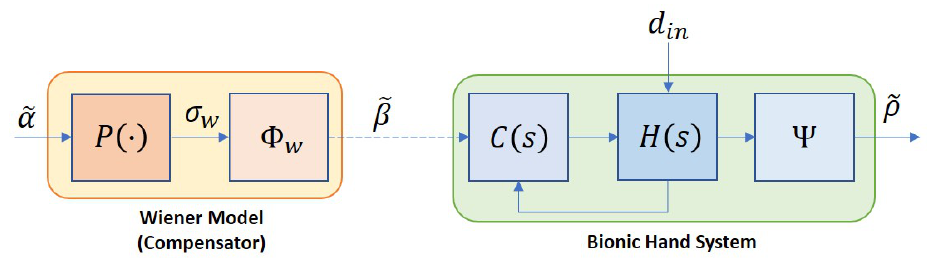
Figure 10. Bionic hand with a Wiener compensator.